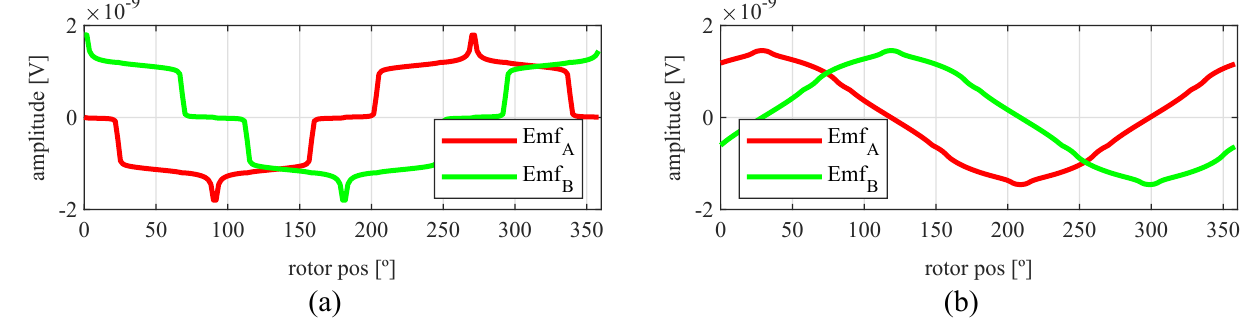
Figure 12. Short pitch four-slot resolver EMFs skewed for the least THD ( a ) before skew and ( b ) with skew.